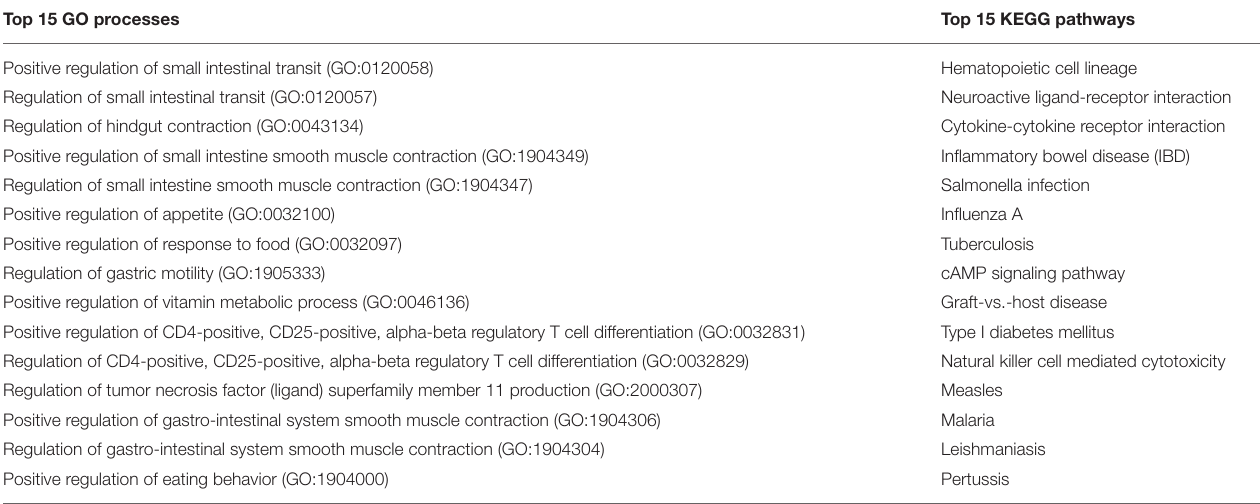
TABLE 6 | Top 15 GO processes and KEGG pathways related to the selected 37 gut-immune genes involved in transport and transit of ingested material.